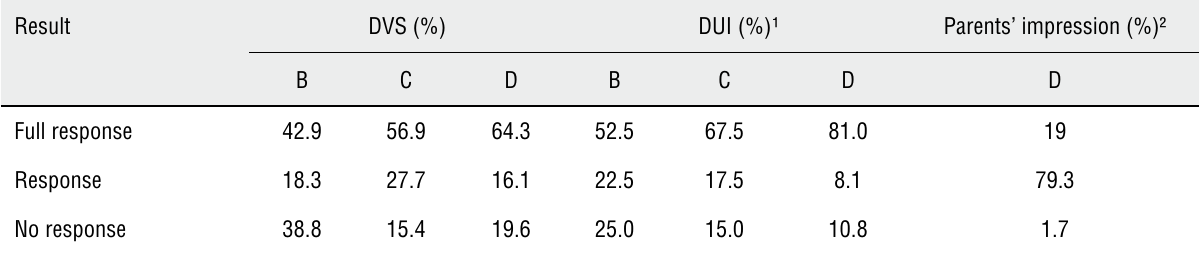
Table 2 - Bladder control training response rate according to dysfunctional voiding score (DVS), daytime urinary incontinence score (DUI), and parents’